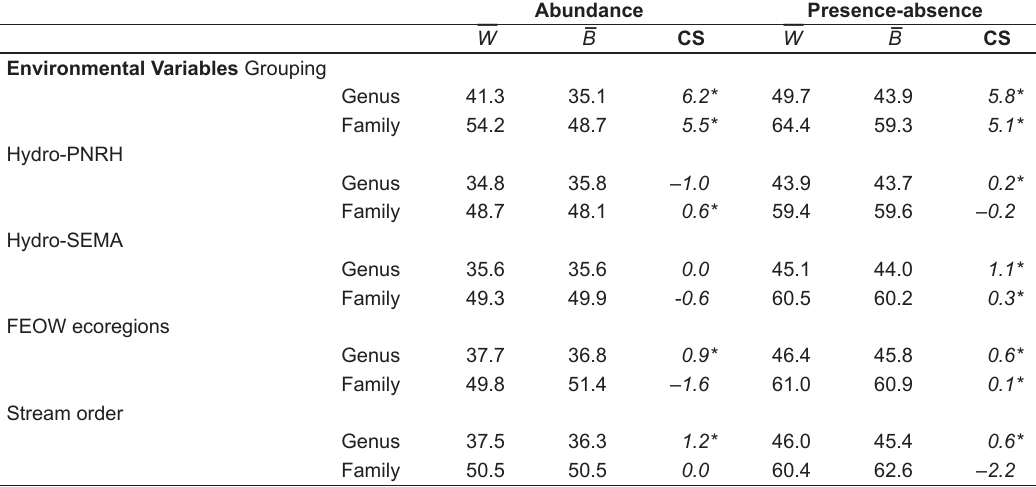
Table 5. Classification Strength ( CS ) results to genus and family. W larity between groups